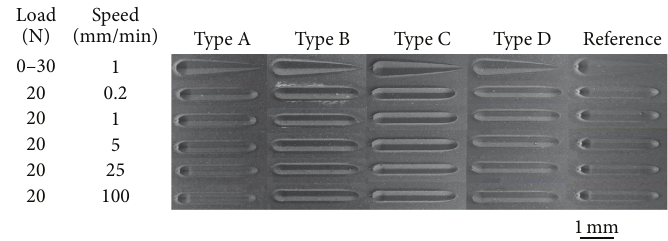
Figure 4: SEM images of the residual scratch patterns.